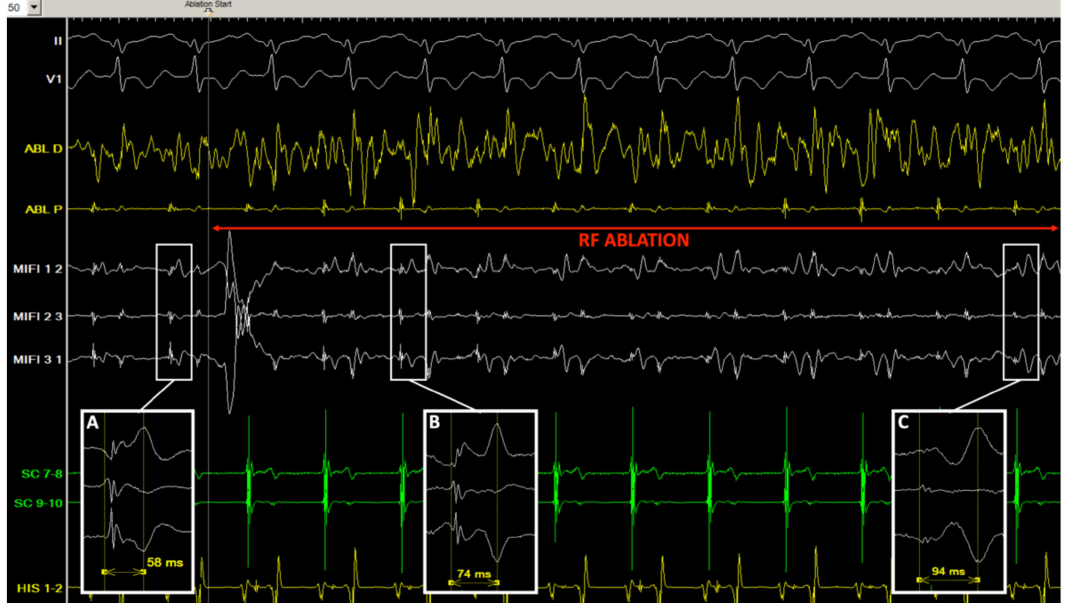
Figure 4. Tracings in patient #7 before and during radiofrequency application. ( A ) Just before ablation, in sinus rhythm, consistent stable double potentials are visualized (separation delay 58 ms) on the mini-electrodes bipolar channels (MIFI 1 2, 2 3, and 3 1) in the slow pathway area; ( B , C ) after 1 s ( B ) and 6 s ( C ) of radiofrequency application (30 W), an incremental double potential interval can be monitored on the insulated mini-electrodes recordings (74 and 94 ms), while the conventional distal ablation channel is completely oversaturated with noise (ABL